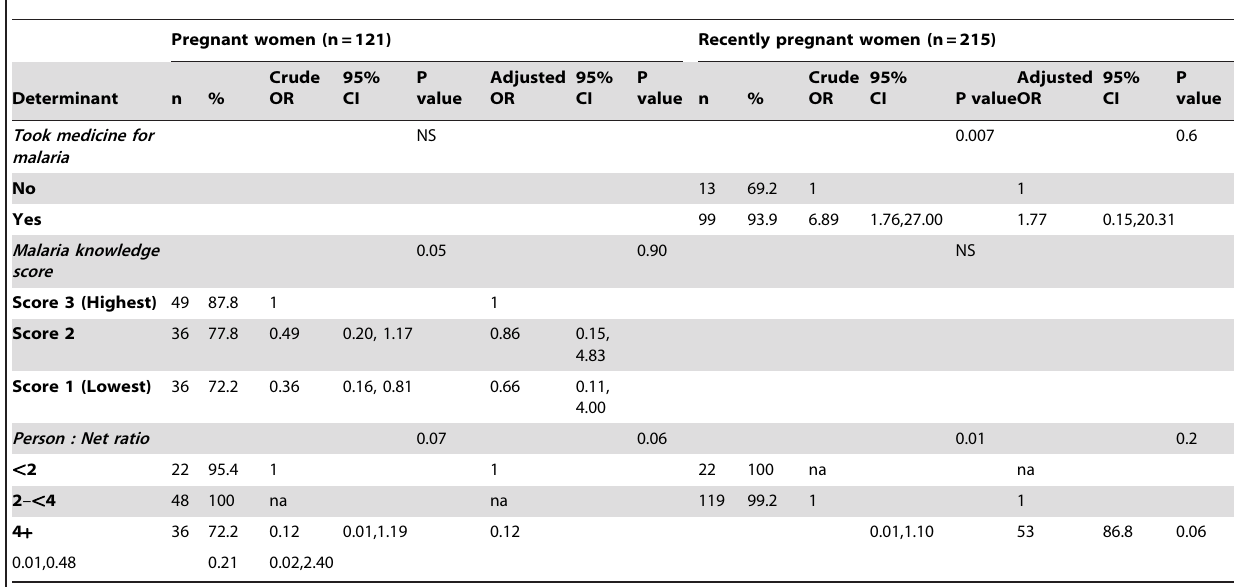
Table 7. Univariate and multivariate analysis of predictors of using an ITN among pregnant women and recently pregnant women.